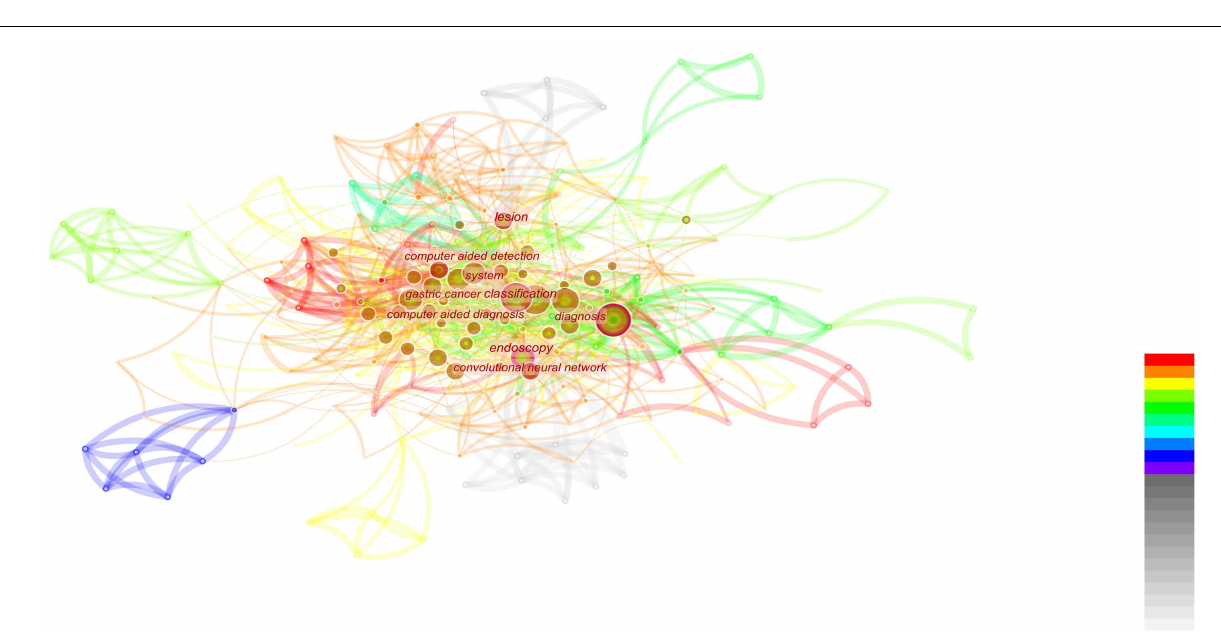
FIGURE 4 | Based on combined images, the studies related to AI are concentrated in the last 3 years, and there is an obvious growth trend.